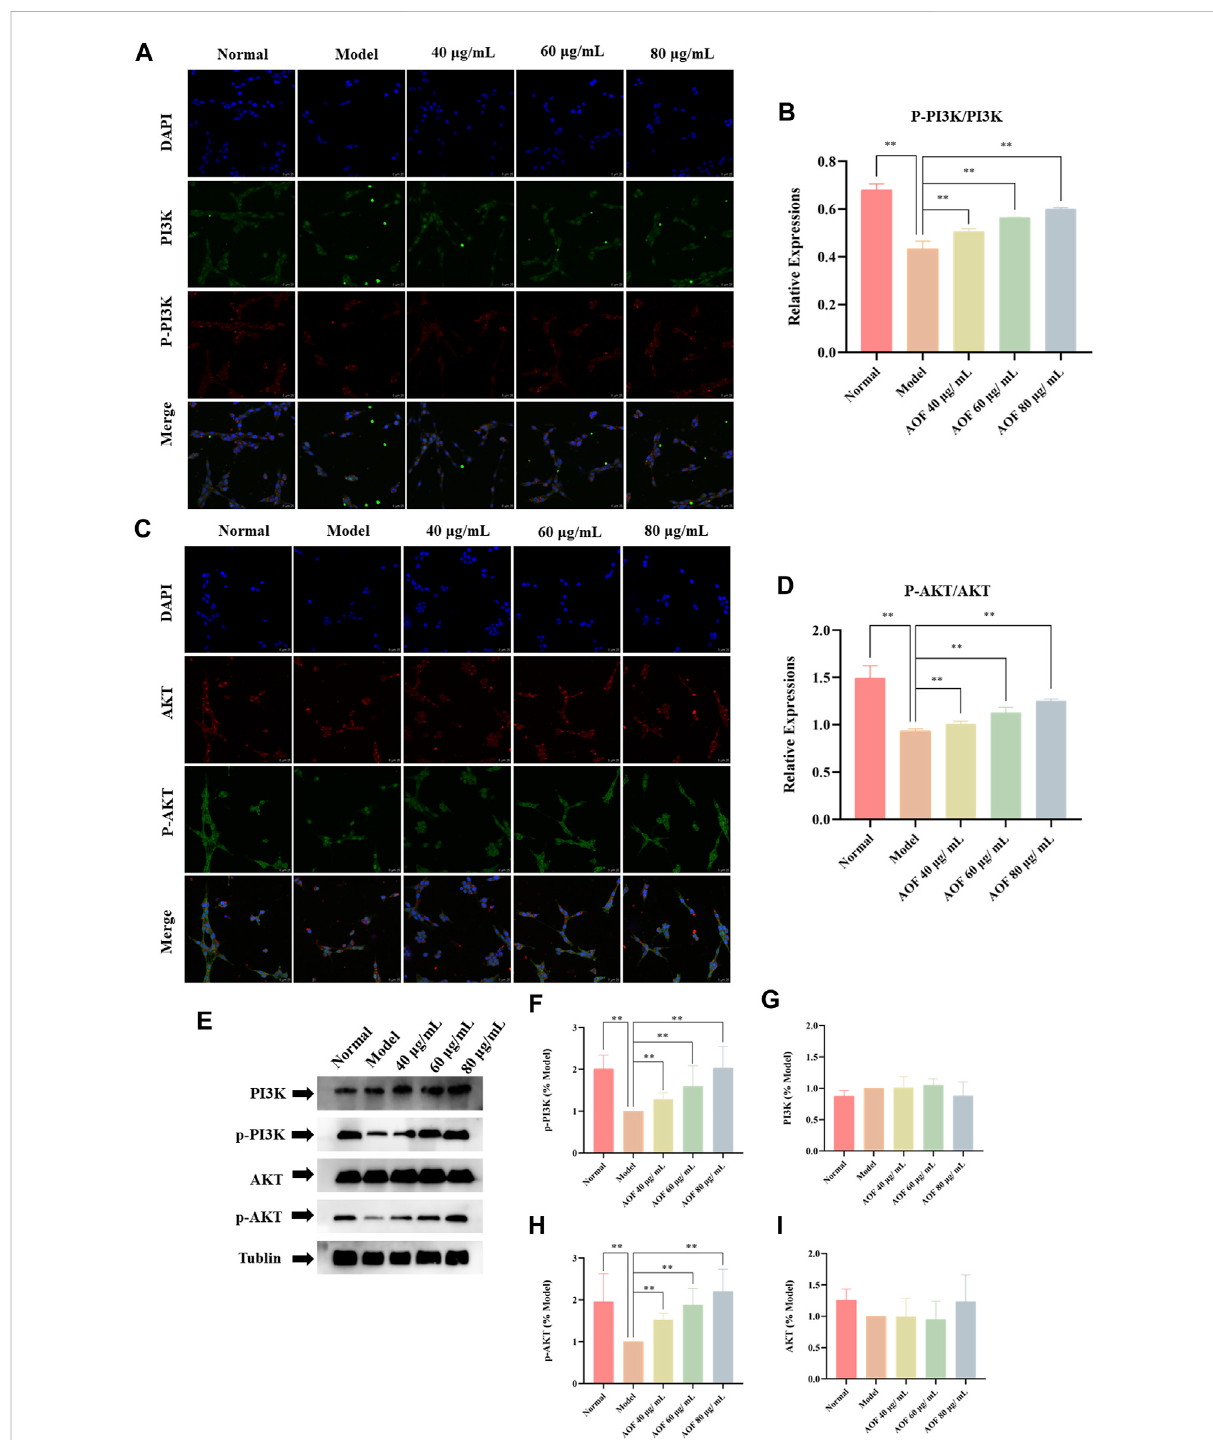
FIGURE 12 Effects of AOF on PI3K/Akt signaling pathway in H 2 O 2 -stimulated PC12 cells (A) IF images of p-PI3K and PI3K (B) Analysis of the p-PI3K/PI3K ratio (C) IF images of p-Akt and Akt (D) Analysis of the p-Akt/Akt ratio (E) WBimages of p-Akt, p-PI3K, AKT and PI3K protein expression (F) Analysis of P-PI3K (G) Analysis of PI3K (H) Analysis of P-Akt (I) Analysis of Akt. Data were expressed as mean ± SD ( n = 3), * p < 0.05, ** p < 0.01 vs